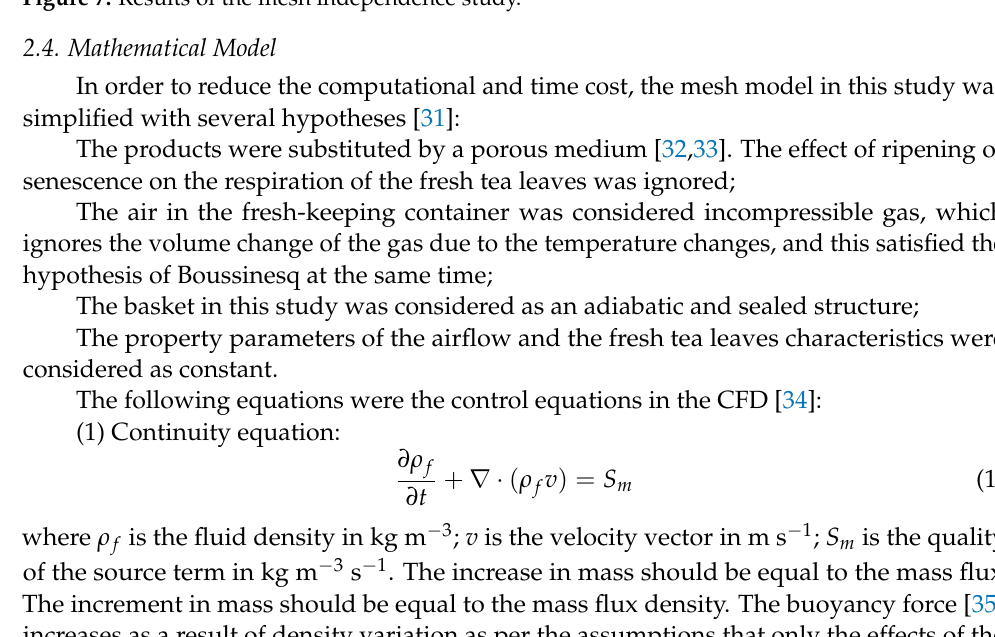
Figure 7. Results of the mesh independence study.